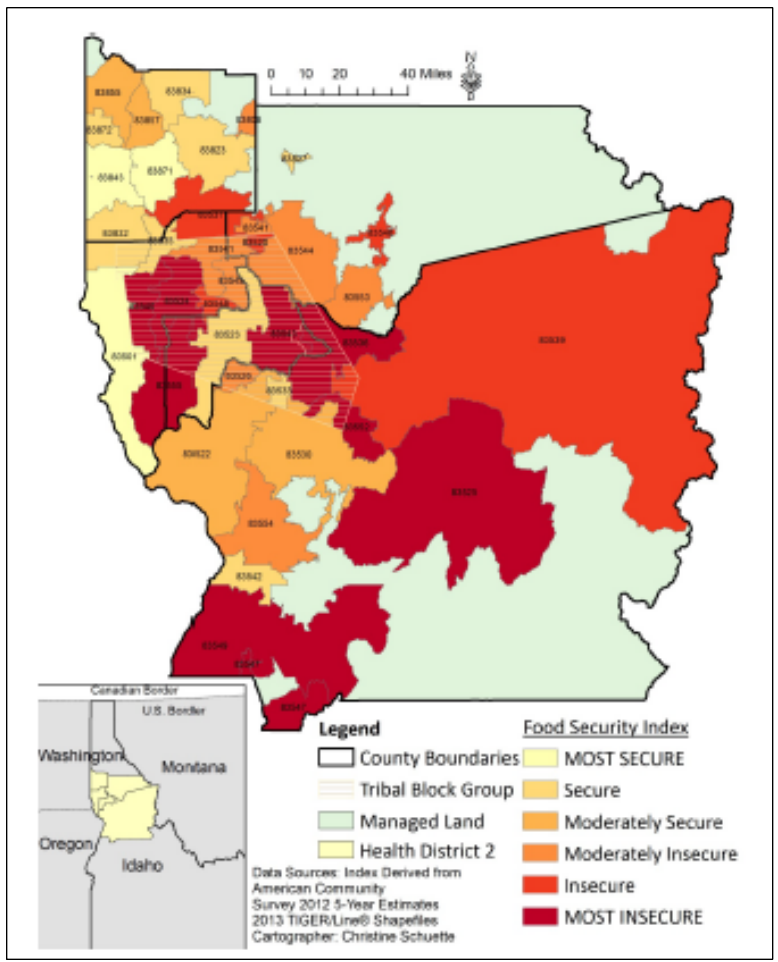
Figure 2. Food Security in the North Central Health District of Idaho